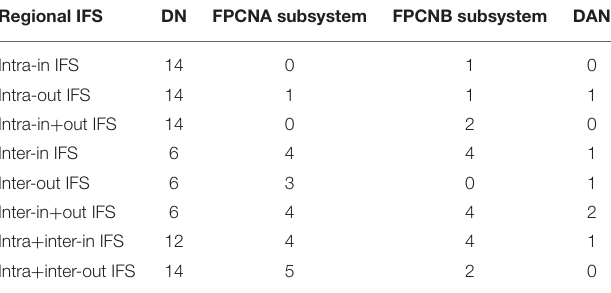
TABLE 2 | The number of ROIs in the brain networks with significant group differences in regional IFS ( p < 0.01). Regional IFS DN FPCNA subsystem FPCNB subsystem